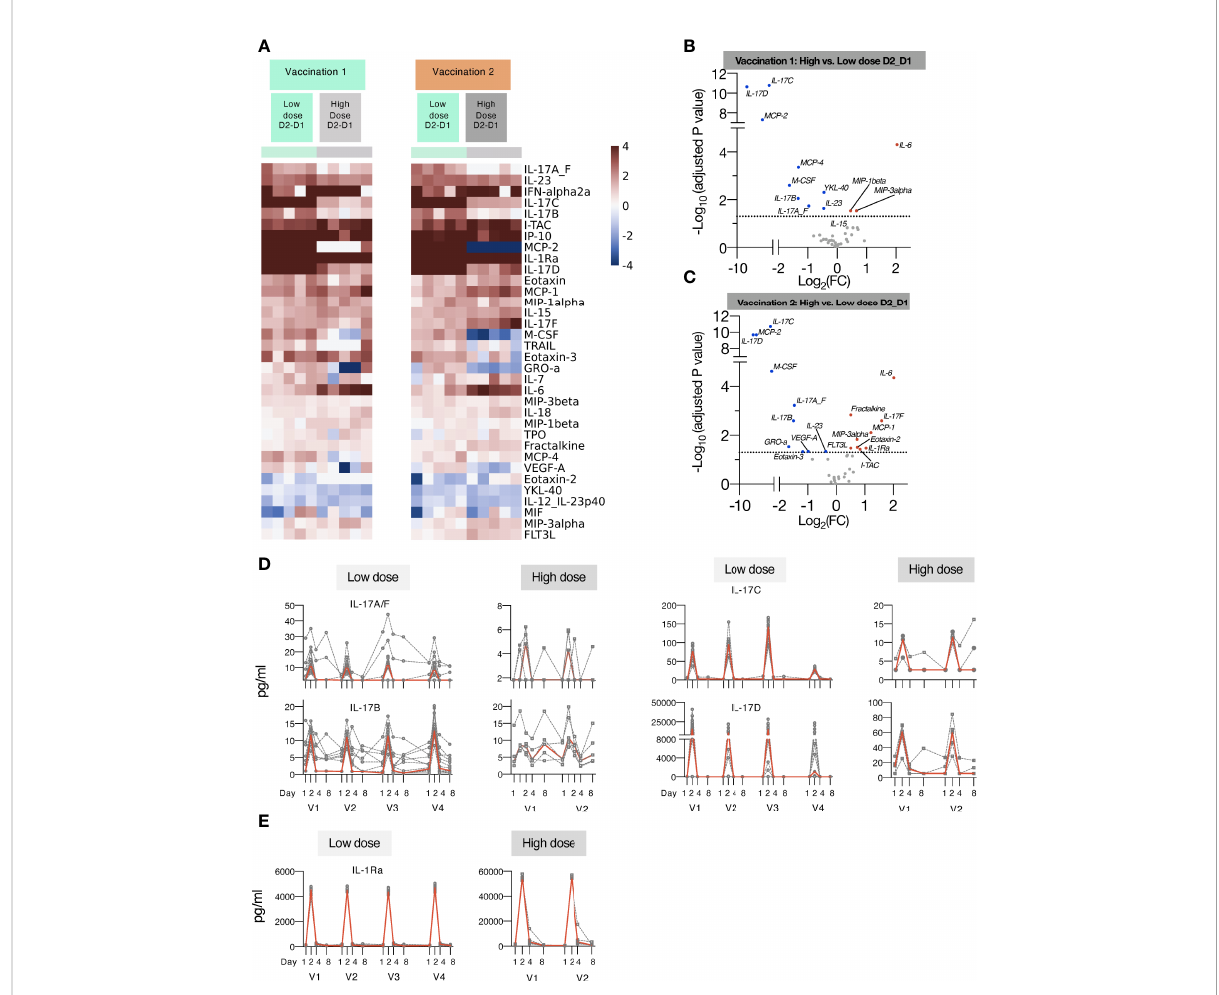
FIGURE 4 Comparison of cytokine and chemokine levels measured in macaques upon low and high dose mRNA/LNP vaccinations. Plasma cytokine and chemokine levels were measured using the MSD assay in macaques after the 1 st and 2 nd mRNA vaccine doses, administered at low (green) or high (grey) mRNA/LNP doses. (A) Heatmap depicts log2 fold changes in 34 analytes detected at 24 hours (D2_D1) after Vaccination 1 (green) and Vaccination 2 (orange). Cytokine levels at D1 before each vaccination are used as baseline. (B, C) Volcano plots of data shown in panel A depict differentially induced changes upon Vaccination 1 (B) and Vaccination 2 (C) between low and high mRNA vaccine doses. Red dots indicate analytes signi fi cantly more upregulated in animals receiving the high dose vaccine; blue dots indicate analytes signi fi cantly more upregulated in animals receiving the low dose vaccine (adjusted p value<0.05 represented by the broken horizontal line). (D, E) Overtime changes in in fl ammatory modulators upon mRNA/LNPs vaccination. Circulating plasma levels of (D) IL-17 family of cytokines (IL-17A/F, IL-17B, IL-17C, IL-17D) and (E) IL-1Ra for individual animals (grey lines) and median (red lines) are shown upon mRNA vaccination, administered at low (left panels) and high (right panels) mRNA/LNP